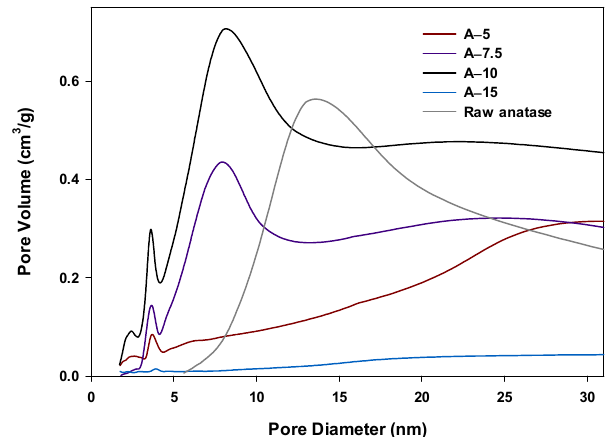
Figure 5. Pore size distribution of titania catalysts originating from anatase.